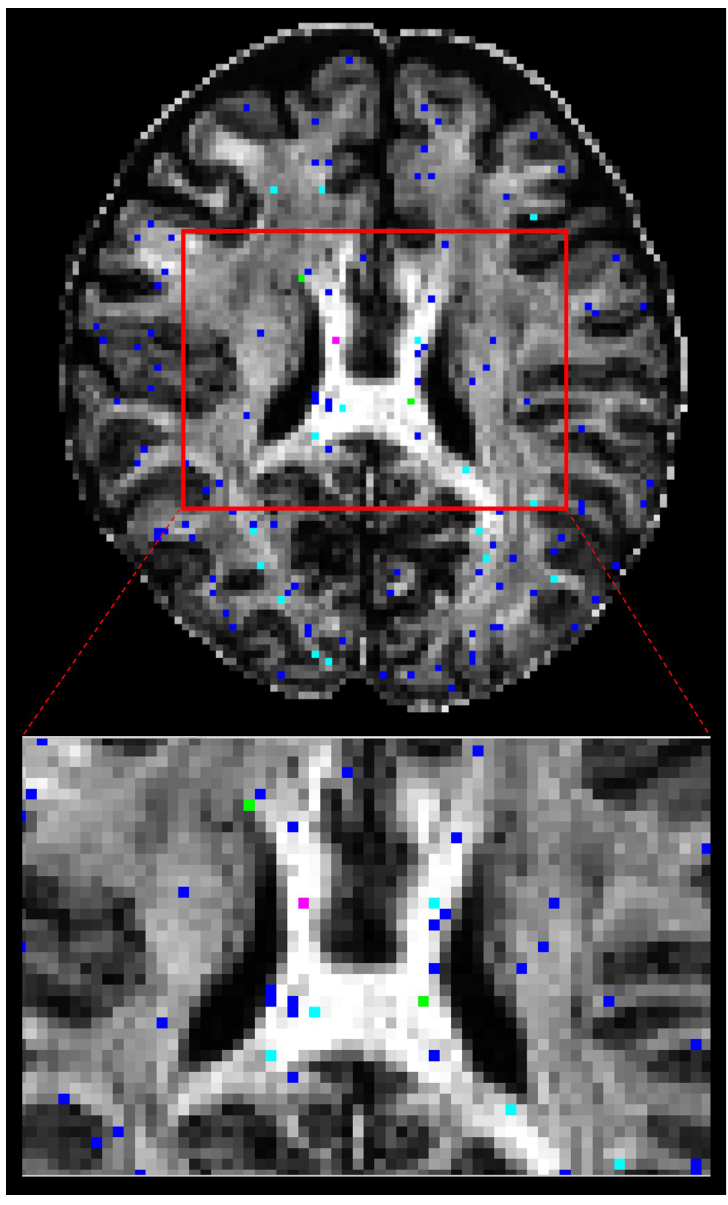
Fig 2. Significantly different f 1 map. Significantly different f 1 overlaid on mean f 1 image. S-score ranges are in: 0.1– 0.2 = blue, 0.2–0.3 = light blue, 0.3–0.4 = green, > 0.4 = magenta (enlarged view from area in